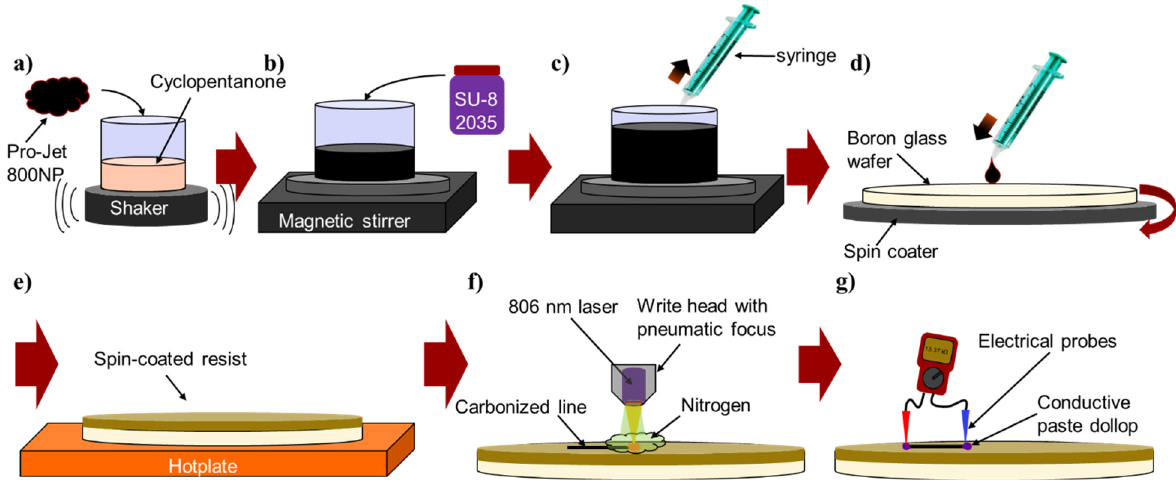
Figure 1. Overview of the preparation, exposure and characterization process: ( a ) absorber addition to solvent; ( b ) SU-8 addition; ( c ) stirring and sample collection; ( d ) sample deposition and spin coating; ( e ) solvent removal by baking on hotplate; ( f ) laser exposure in nitrogen atmosphere; ( g ) electrical characterization.